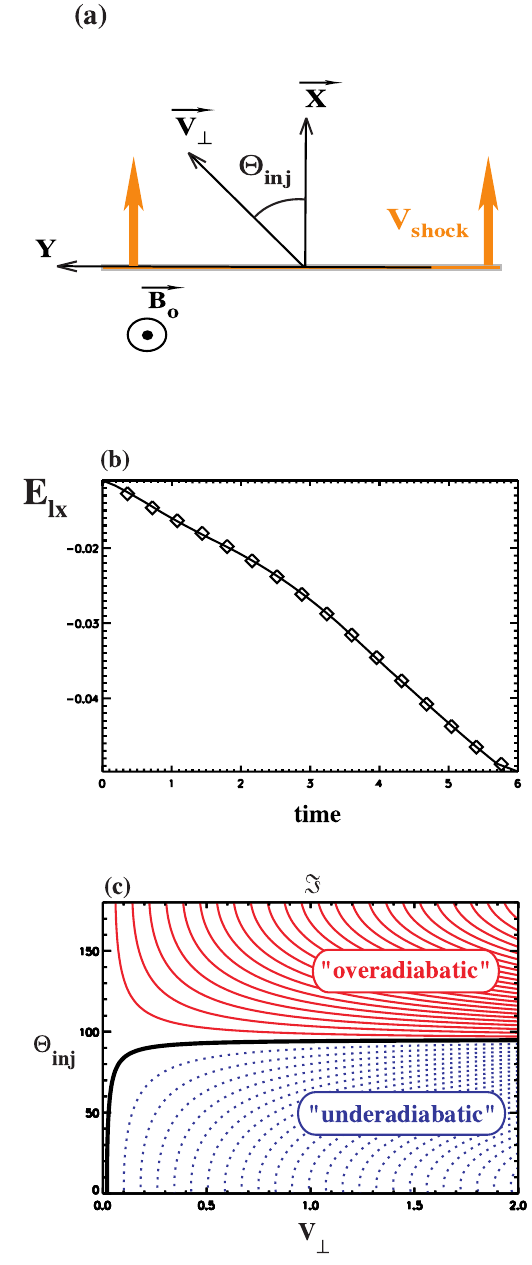
Fig. 5. (a) Sketch of the two-dimensional simulation shock front where the injection angle θ inj is defined between the normal n of the shock front (along x ) and the local gyrating perpendicular ve- locity. The upstream magnetostatic field B o is outside the simu- lation plane. (b) Enlarged view of time history of the electrostatic field component seen by the injected particles (thin line), within the ramp. A best fit is performed with a 4 th order polynom to get the a n coefficients used in our theoretical model and is represented by the squares. (c) plot of the quantity = (Eq. 5) versus the injection angle θ inj and v ⊥ (gyrating velocity). The adiabatic line (thick line) sep- ares the two nonadiabatic populations: (i) the “under-” (blue dashed lines) and the (ii) “over-adiabatic” electrons (red thin